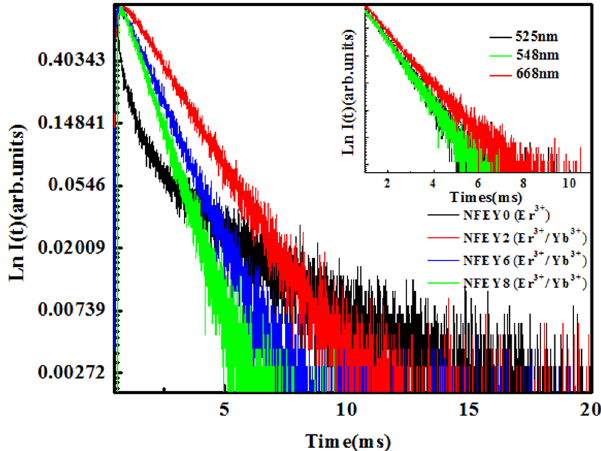
Figure 4. Decay curves of the Er 3 + /Yb 3 + co-doped Na 5 Lu 9 F 32 single crystals surveyed at 548 nm under 980 nm excitation, and the inset is the decay times centered at 525, 548 and 668 nm for 1.0% Er 3 + /8% Yb 3 + co-doped Na 5 Lu 9 F 32 single crystal.